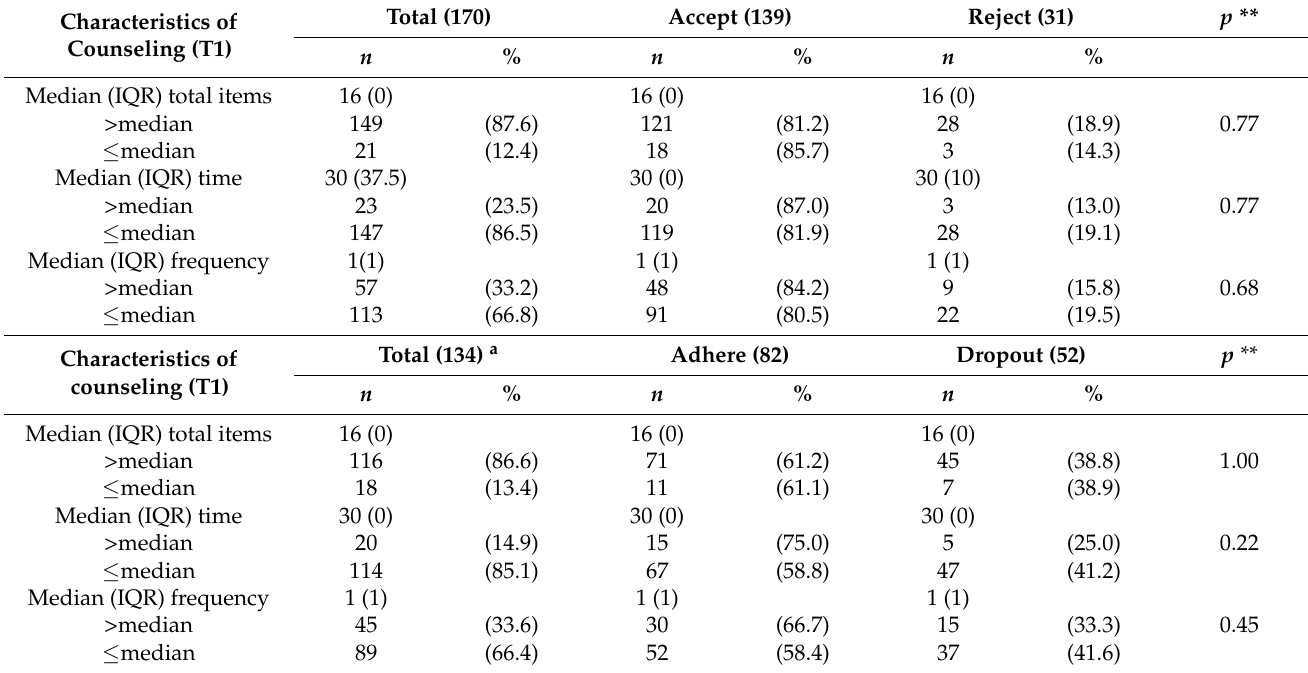
Table 3. Analysis of counseling to ART acceptance and ART dropout at 6 months follow